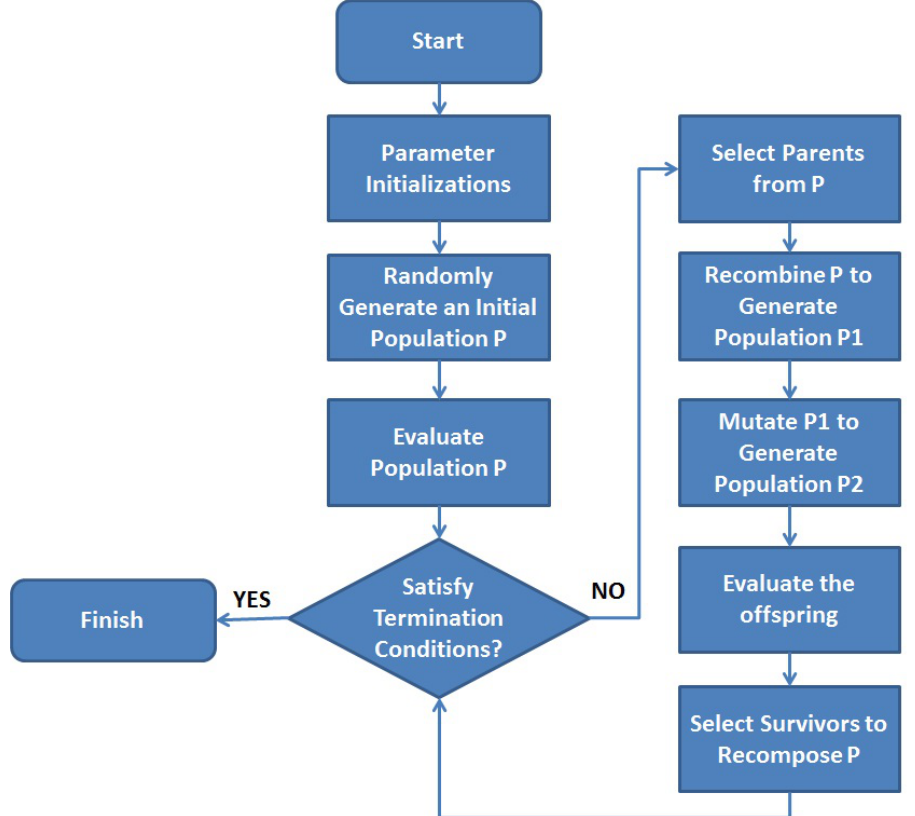
Figure 1. Generalized design of evolutionary